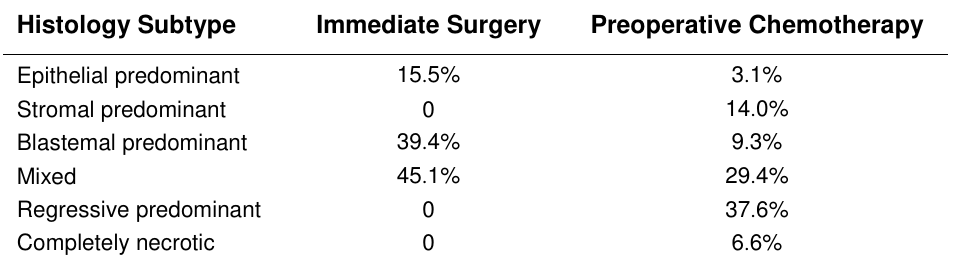
Histological Subtypes of WT in Immediate Surgery vs. Preoperative Chemotherapy Histology Subtype Immediate